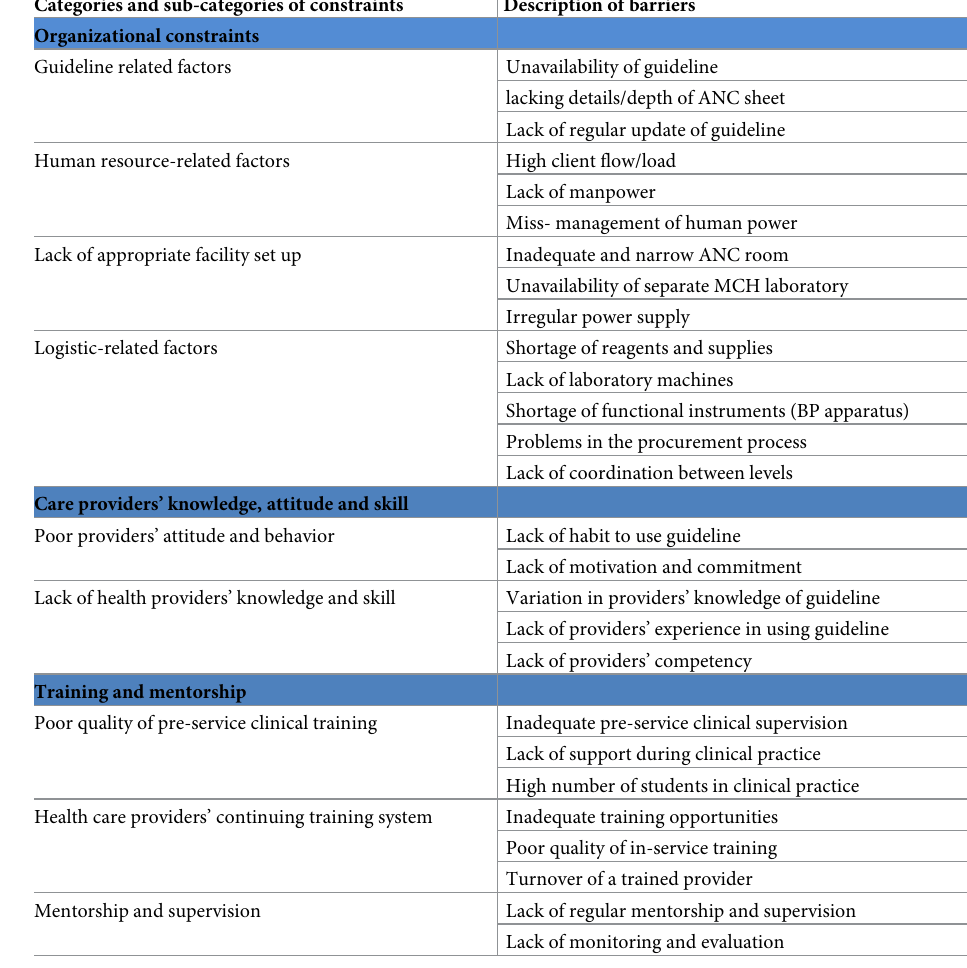
Table 2. Challenges that affect the complete adherence to ANC